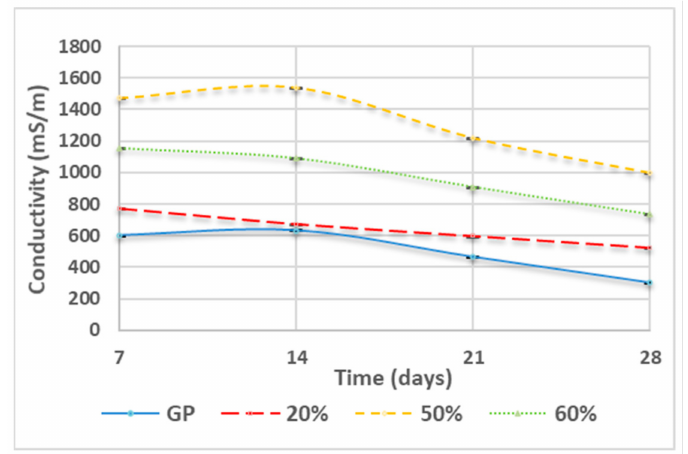
Figure 5. Conductivity of GP and GP/WG (20, 50 and 60%) at different curing times. Error associated with this measurement is approx.